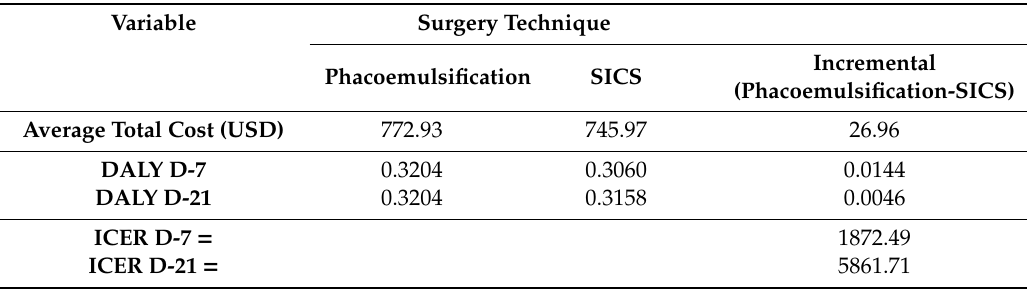
Table 5. Distribution Frequency of the Incremental Cost E ff ectiveness Ratio